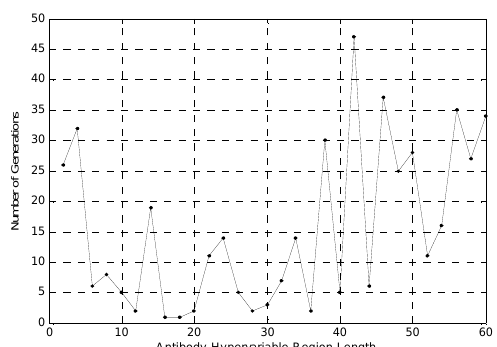
Fig. 13. Sensitivity of Antibody Hypervariable Region Length L h